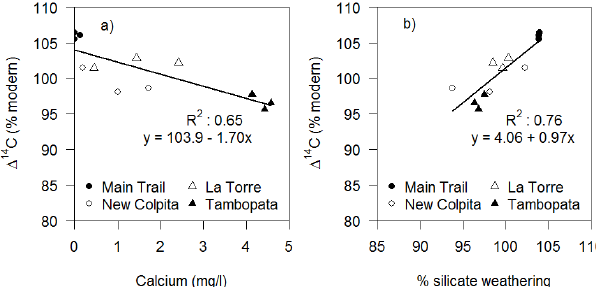
Figure 3. Across the drainage systems, 14 C concentration (%mod- ern) was significantly correlated with calcium concentration (a) and percentage silicate weathering (b) . Silicate weathering percent- age calculated from the bicarbonate concentration using expected in-stream concentrations in pure carbonate and silicate lithologies from Meybeck